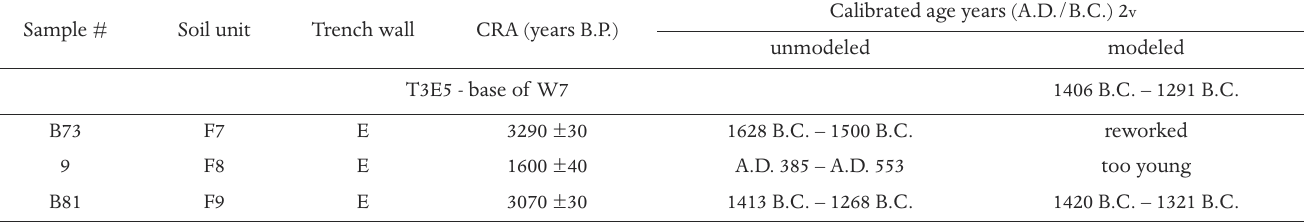
Table 2 (continues from previous page). Summary of sample radiocarbon ages from this study. CRA, conventional radiocarbon aAge [Stuiver and Polach 1977]. A table with more extensive data is presented in Table A.B-1 (Annex B). Figure 9 is a graphical presentation of the order-constrained Bayesian model (electronic supplement 1) compiled using selected samples from trench